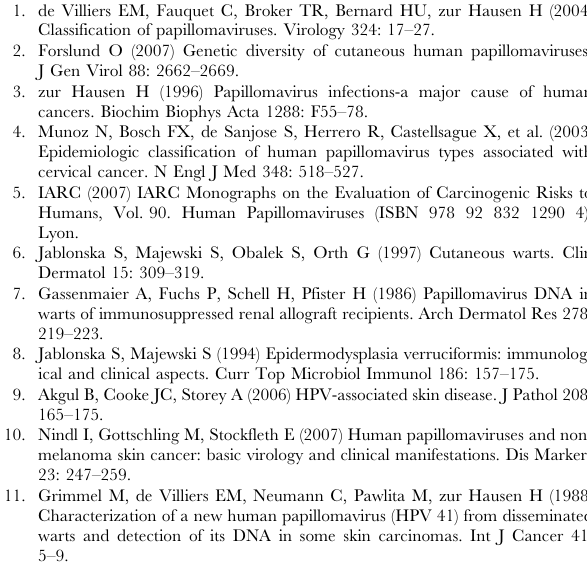
Figure S1 Double seropositivity in relation to amino acid sequence identity of the paired HPV L1